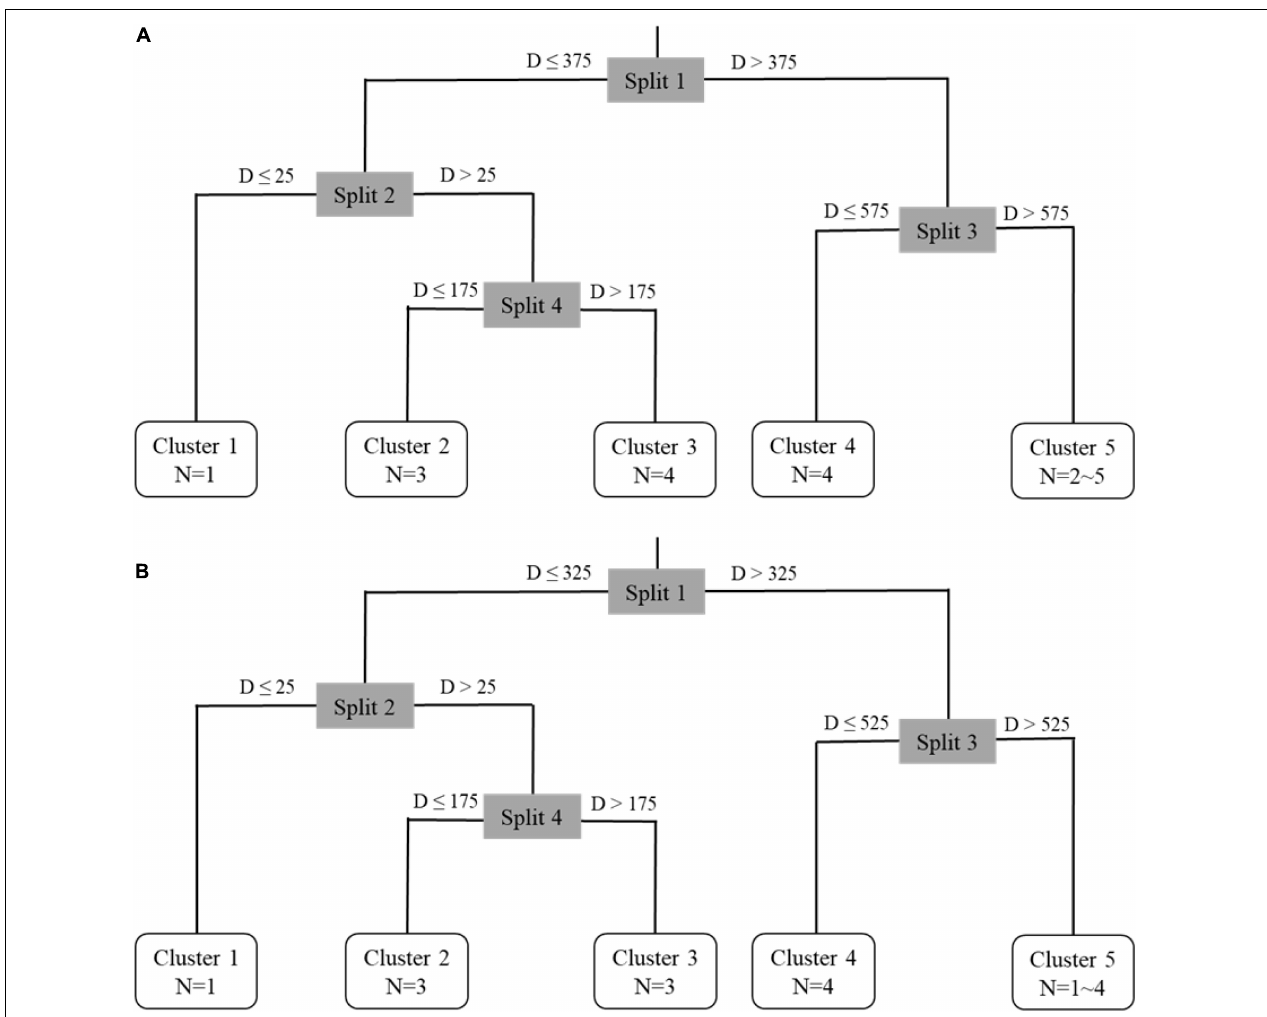
FIGURE 5 | Multiple regression tree analysis results for autumn cohort (A) and winter-spring cohort (B) of Ommastrephes bartramii . D represents the length from the core and N represents the number of ablation spots measures.